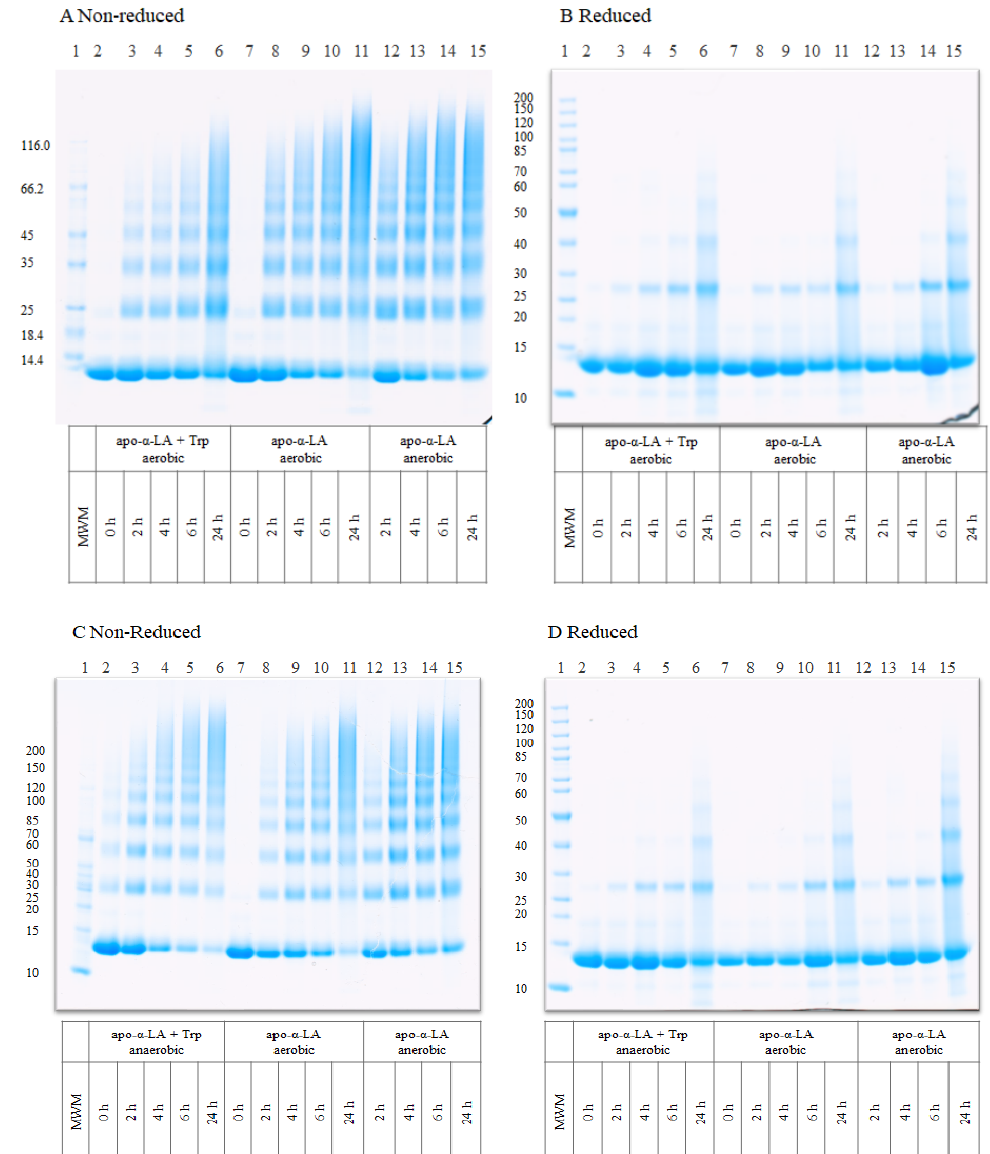
Figure 1. SDS-PAGE of apo- α -LA with or without the addition of 2.8 mM Trp prepared under aerobic and anaerobic conditions in 50 mM HEPES buffer, pH 7.0 after UV-B illumination for 0, 2, 4, 6, and 24 h. ( A ) Non-reduced samples of apo- α -LA with added free Trp under aerobic conditions and apo- α -LA under aerobic and anaerobic conditions. ( B ) Reduced apo- α -LA samples as described in A. ( C ) Non-reduced samples of apo- α -LA with added free Trp under anaerobic conditions and apo- α -LA under aerobic and anaerobic conditions. ( D ) Reduced apo- α -LA samples as described in C. Reduced samples were added DTT, and all gels were stained with Coomassie brilliant blue. Molecular weight markers (MWM) were included on each gel. Representative gels of three independent experiments are shown.